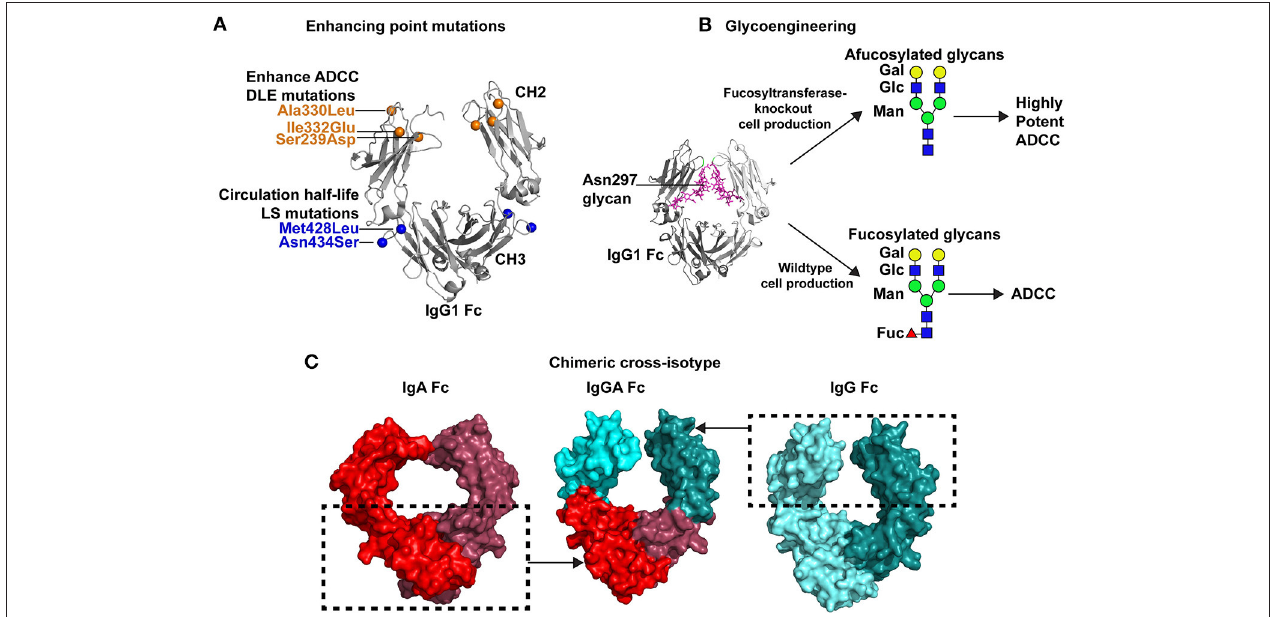
FIGURE 2 | Strategies for improving antibody Fc-mediated effector functions. (A) Multiple point mutations have been identified that improve binding affinity of Fc for specific Fc γ Rs. In some instances a single Fc γ R, such as Fc γ RIIIa is the receptor of interest. Directed evolution, alanine scanning, or structure-guided design have been used to identify these mutations. An example of these mutations is the DLE (Ser239Asp/Ile332Glu/Ala330Leu) set of mutations that are shown in the crystal structure of the Fc by orange spheres (PDB:3DO3; 42). These mutations improve ADCC activity. Additionally, mutations can be inserted that improve antibody circulation in vivo . The LS mutations, depicted by blue spheres, (Met428Leu/Asn434Ser) are one example of antibody half-life extension mutations. (B) Antibody effector functions can be enhanced by glycoengineering the Fc domain. The Fc domain contains a N-linked glycan at position 297. A crystal structure of the IgG1 Fc (gray) and the N297 glycan (magenta) are shown (PDB:4BYH). Expression of antibody in wildtype cells results in a fucosylated complex glycans present at N297. However, specialized cells have been created with fucosyltransferase knocked out, which results in afucoylated glycans at Asn297. Antibodies with afucosylated glycans exhibit upto 50-fold more potent ADCC than the same antibody with a fucosylated glycan at Asn297 ( 60). Green circles, mannose; blue squares, GlcNAc2; yellow circles, galactose; and red triangles, fucose. (C) Antibody effector functions can be improved by expanding the breadth of Fc receptors capable of interacting with Fc. To improve antibody effector function the Fc of a single antibody can be engineered to bind to Fc receptors for multiple antibody isotypes. This concept has led to the design of cross-isotype IgGA antibodies (center) where the IgG1 CH2 a1 loop residues 245–258 and the IgG1 CH3 domain (cyan) were exchanged with the structurally analogous regions of IgA ( 54). The regions inside the dashed box were combined to create a chimeric cross-isotype Fc. The IgG1 segments are colored light and dark cyan (right, PDB: 3DO3), and the IgA segments are colored light and dark red (left, PDB: 1OW0). The cross-isotype Fc is capable of binding to Fc γ RI and Fc α RI, hence either of these Fc receptors can be used to recruit diverse effector cells to target cells (